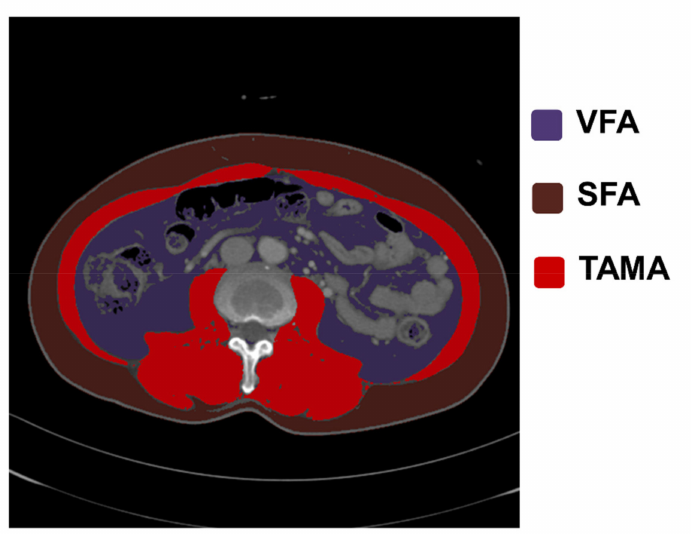
Figure 2. Evaluation of body composition of abdominal fat and muscle area. An axial CT image segmented into the visceral fat area (VFA), subcutaneous fat area (SFA), and total abdominal muscle area